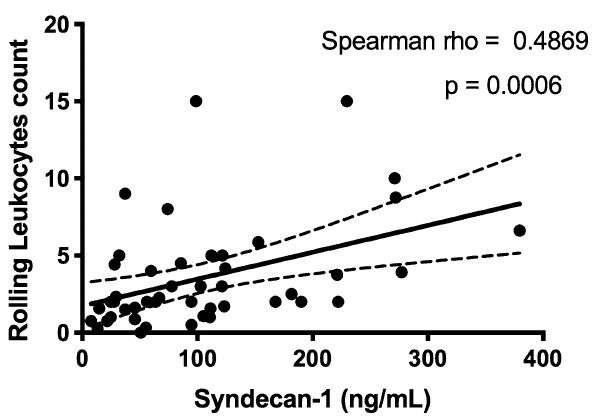
Figure 9. Correlation between Syndecan-1 and sublingual microcirculatory rolling leukocytes. Syndecan-1 levels and the sublingual microcirculatory rolling leukocyte counts show a significant but moderate